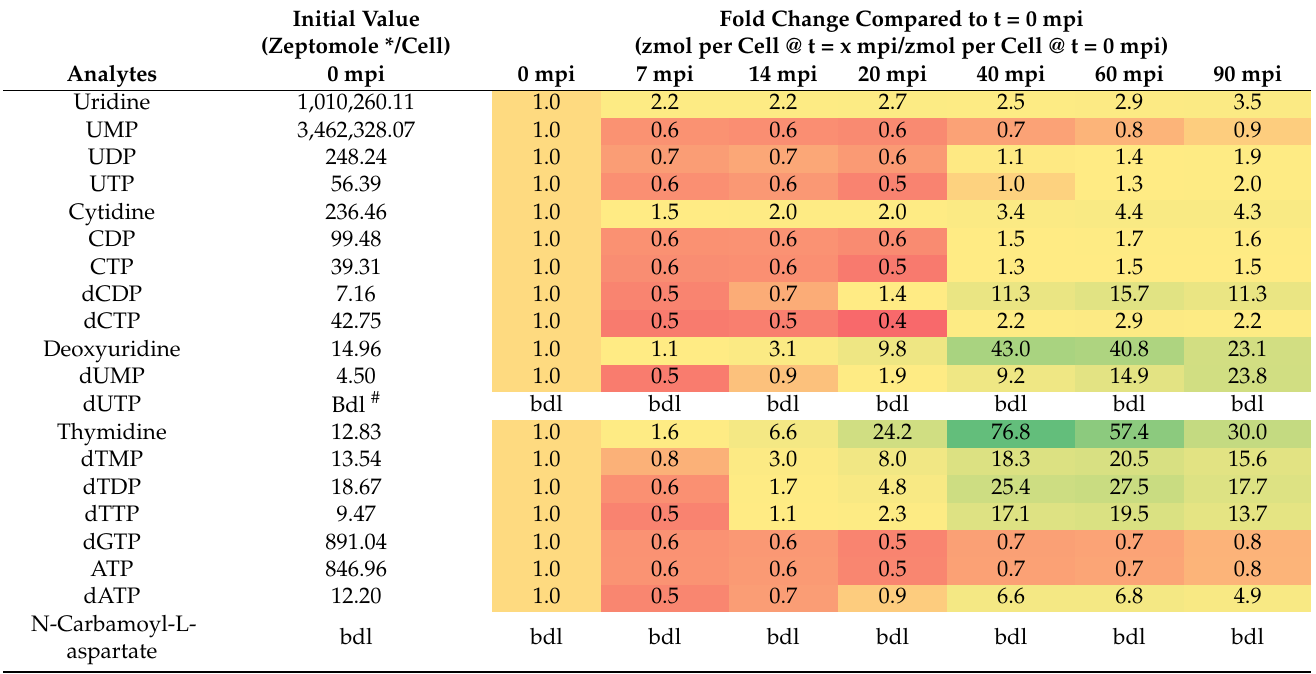
Table 2. Heat map of nucleotide metabolite amounts per cell versus time of infection.